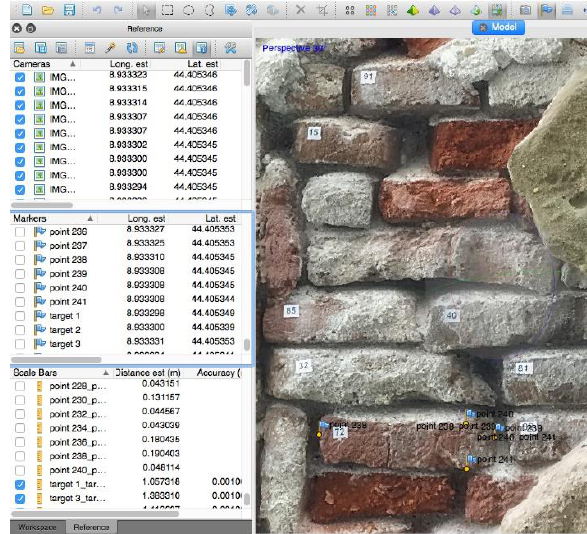
Figure 3. In case A and B, the bricks were identified on site with numbered labels to compare the results of direct and digital measurements block by block. The image displays inserted markers for brick n. 72.